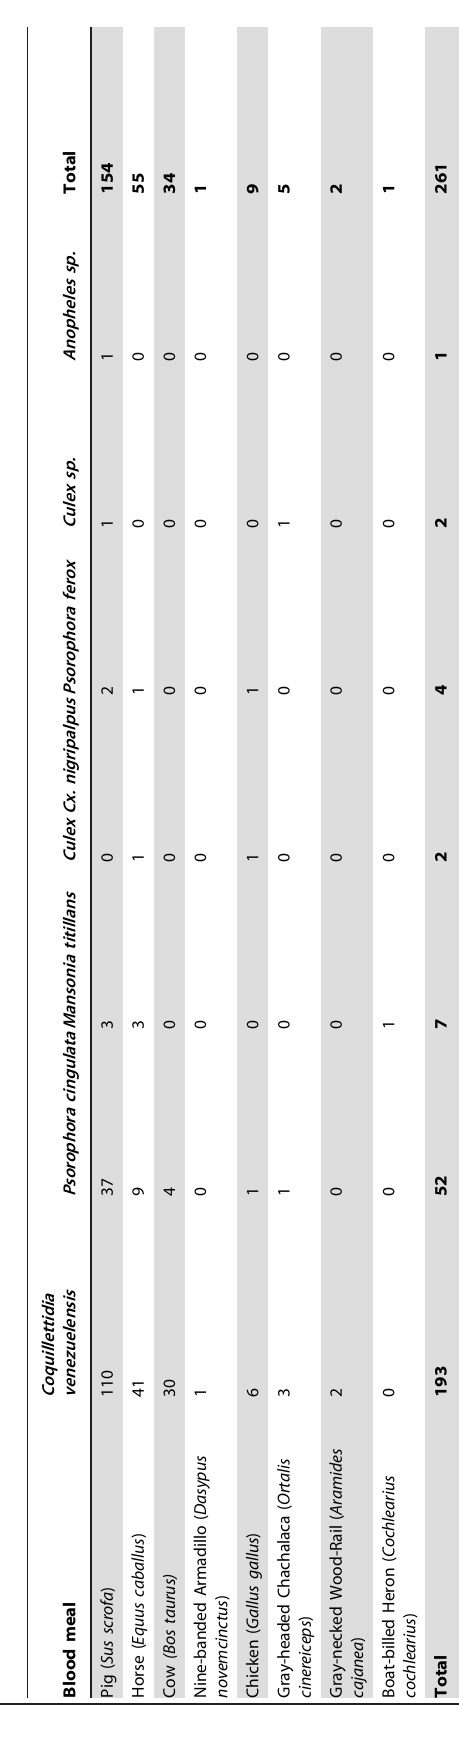
relative abundance among recovered blood meals and moderate estimated